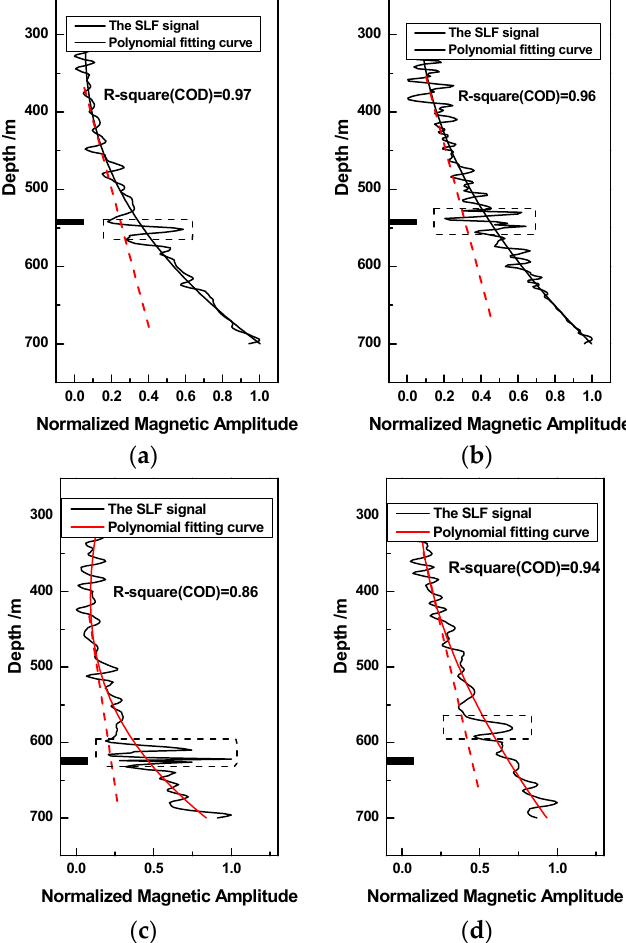
Figure 17. Extraction of electromagnetic radiation (EMR) anomalies from measured magnetic am- plitude curves. Note: ( a , b ) The original data were collected from the vicinity of Wells 1-4 in the Qinshui Basin in May 2010 and August 2011. The reservoir drilling revealed that the burial depth was 543.8–546.5 m; ( c , d ) The raw data were collected from the vicinity of Wells 1-5 in the Qinshui Basin in August 2011 and June 2012, respectively. The solid black and red lines represent the polynomial fit curve, and the dashed red line represents the trend line. The solid black rectangles represent the reservoir locations, while the dashed boxes give the EMR anomaly distribution and interpret the burial